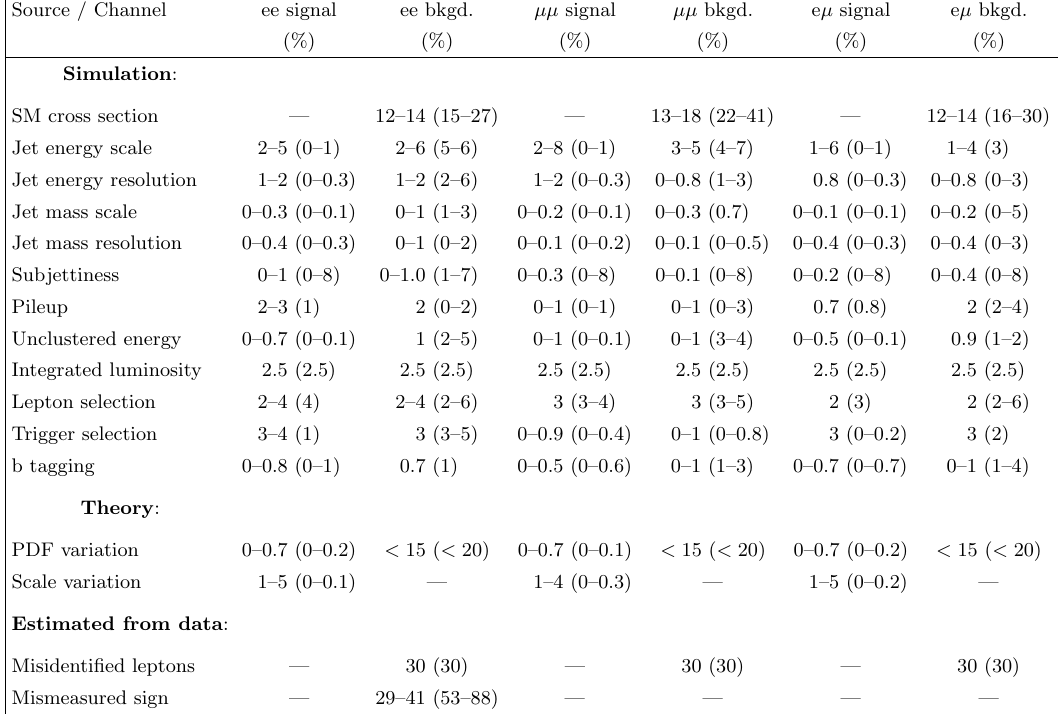
Table 4 . Summary of the relative systematic uncertainties in heavy Majorana neutrino signal yields and in the background from prompt SS leptons, both estimated from simulation. The relative sys- tematic uncertainties assigned to the misidenti(cid:12)ed-lepton and mismeasured-sign background esti- mated from control regions in data and simulation are also shown. The uncertainties are given for the low- (high-)mass selections. The range given for each systematic uncertainty source covers the varia- tion across the mass range. Upper limits are presented for the uncertainty related to the PDF choice in the background estimates, however this source of uncertainty is considered to be accounted for via the normalization uncertainty and was not applied explicitly as an uncertainty in the background.